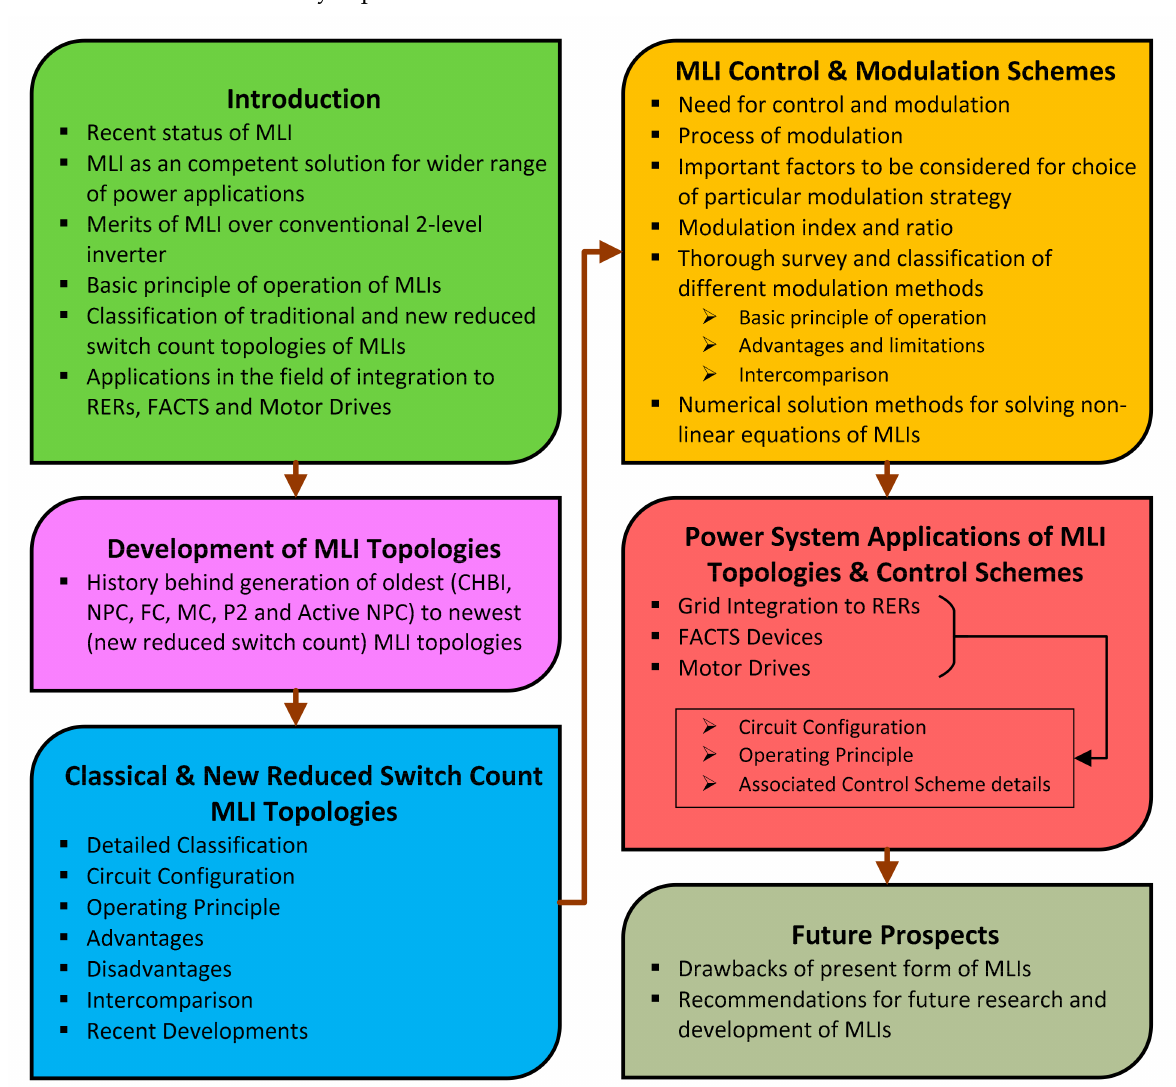
Figure 1. A summary of the review methodology adopted in the present research